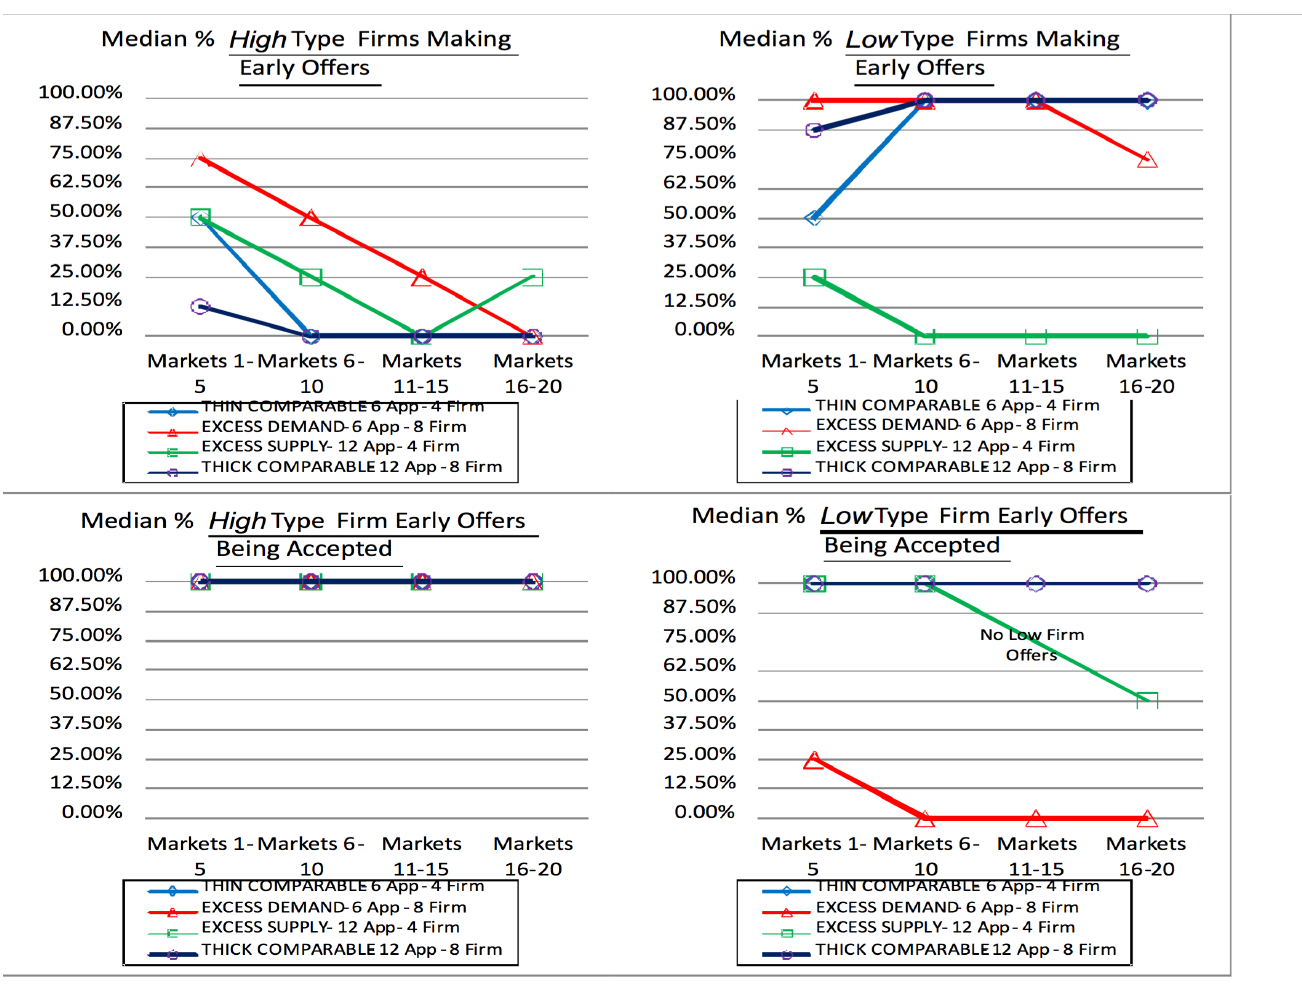
Figure 2. Median early offer rates and acceptance rates across